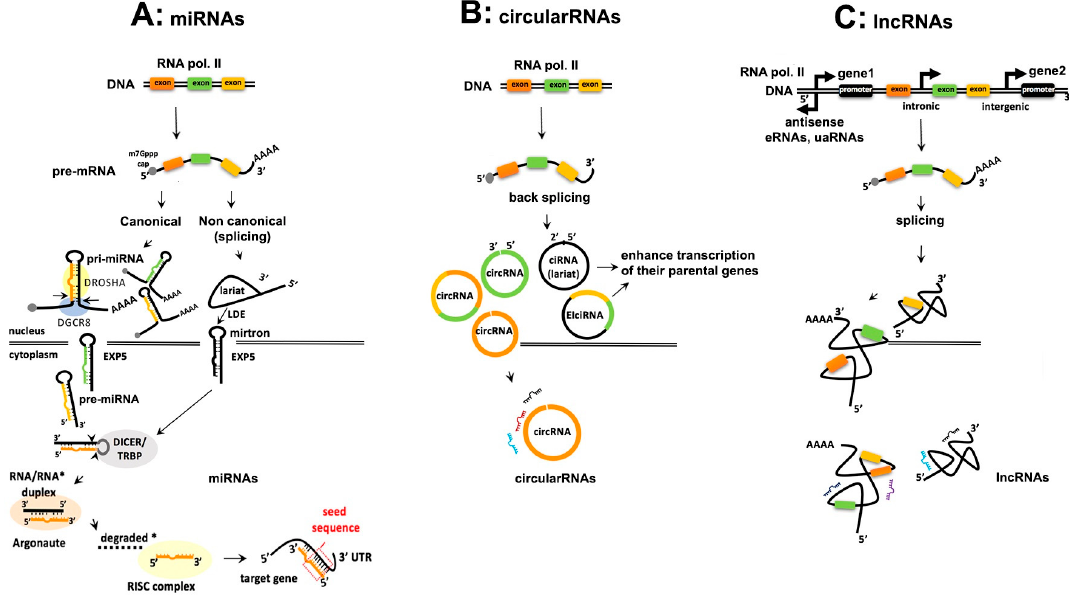
Figure 1. An overview of biogenesis of ( A ): miRNAs, ( B ): circular RNAs and ( C ): lncRNAs. NcRNAs are first generated in the nucleus, transcribed by polymerase II giving rise to a long, sometimes hundreds of kilobases 5 ′ capped and 3 ′ polyadenylated transcripts. ( A ): Canonical miRNA: DGCR8 and Drosha bind and cleave the basal stem of pri-miRNAs to liberate the stem-loop pre-miRNA that enters the cytoplasm by Exportin 5 (EXP5) where the pre-miRNA loop is cleaved by the RNase III Dicer and HIV-1 TAR RNA binding protein (TRBP) to form a mature RNA duplex. One of the two strands, the guide strand, is selected by one of the four Argonaute (AGO) proteins and loaded together with the passenger strand in the RNA induced silencing complex (RISC). The passenger strand is degraded while the guide strand will become the mature miRNA. Non-canonical miRNAs: mirtrons: reside in introns at the exon junction site of the pre-mRNA, are spliceosome-dependent and have their own processing mechanism, which is independent from microprocessor complex. Mirtrons form lariats which are debranched under the action of lariat debranching enzymes (LDE) to fold into the pre-miRNA hairpin and proceed through the canonical miRNA pathway maturation. ( B ): Circular RNAs: The canonical spliceosomal machinery produces 3 ′ -5 ′ backspliced circular pre-mRNA transcripts that are composed of exons (exonic circRNAs), or 2 ′ -5 ′ lariats (intronic RNAs, ciRNAs) and exon-intron circRNAs (EIciRNAs). CiRNAs and ElciRNAs remain in the nucleus in contrast to the circRNAs, which are transported in the cytoplasm. ( C ): LncRNAs: Based on their location in the genome, lncRNAs may be long intergenic (lincRNAs), between two adjacent genes or intronic or within the intron of a protein-coding gene. Antisense lncRNAs as uaRNAs or eRNAs are transcribed in an opposite direction from the host gene. Intergenic and intronic lncRNAs are spliced from the pre-mRNA, through the spliceosomal machinery and can be polyadenylated or not. One of the functions of lncRNAs is to decoy miRNAs.